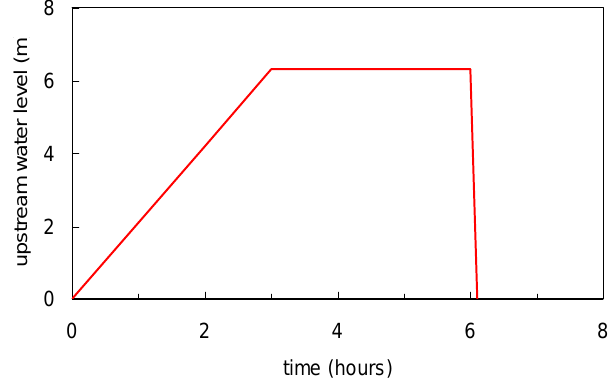
Fig. 9. Hydraulic head condition variable with time applied in the Figure 9 - Hydraulic head condition variable with time applied in the seepage analysis to the 5 seepage analysis to the upstream slope boundary. upstream slope boundary 6